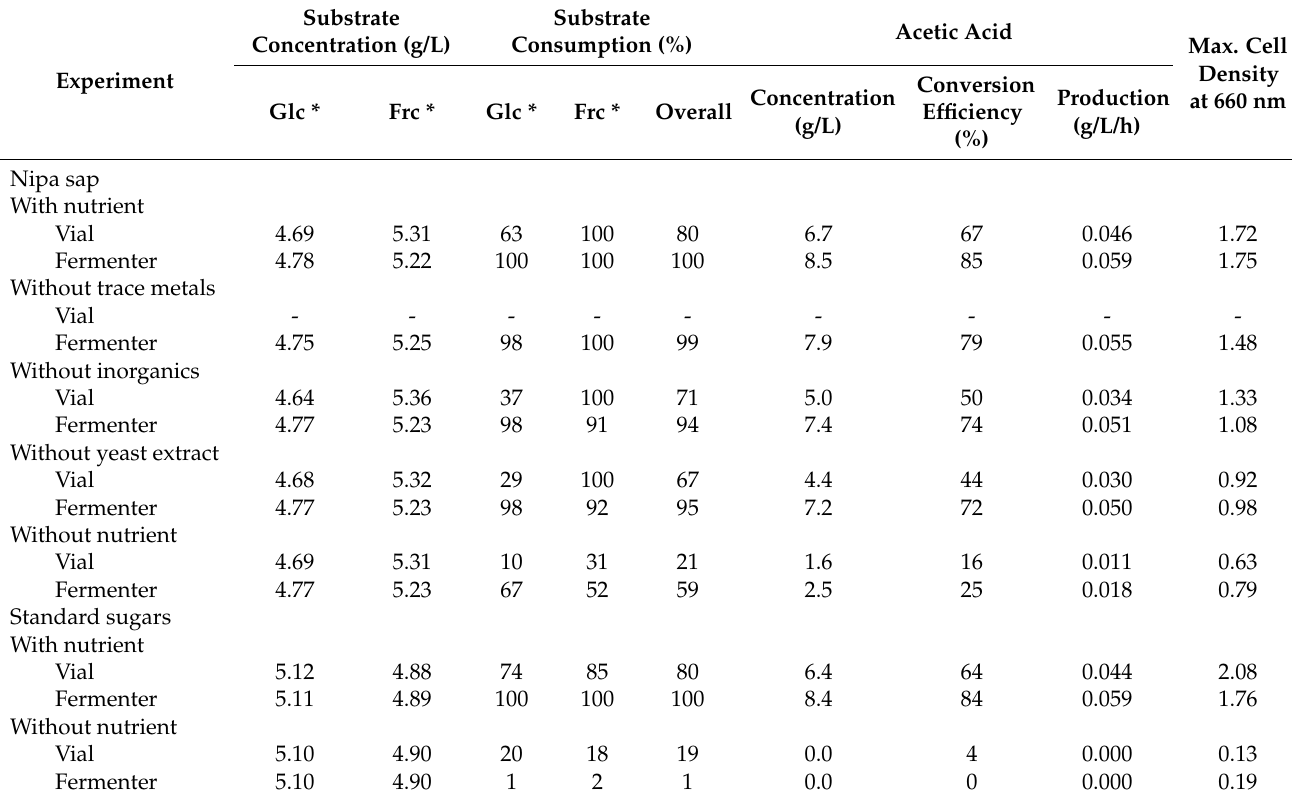
Table 4. Summary of fermentation in vials and fermenters of 10 g/L hydrolyzed nipa sap and 10 g/L